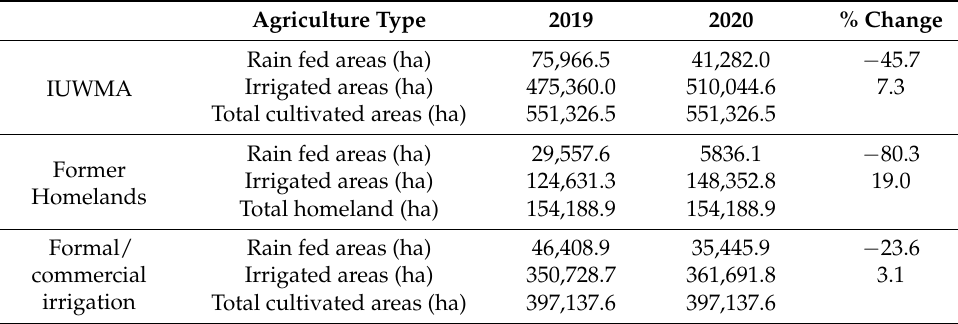
Table 6. Percentage change in the cultivated areas between 2019 and